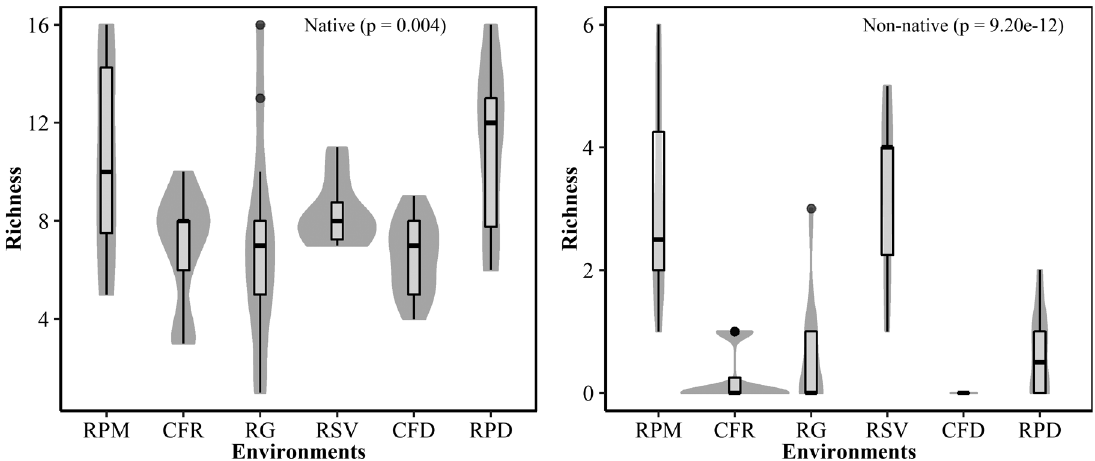
FIGURE 4 | Observed fish-species richness vs . environments. Violin plot comparing the median, interquartile range, and 95% confidence interval on the distribution pattern of richness among environments (left: native fish, right: non-native fish). The shape of the violin plot represents data distribution by kernel-density estimation, meaning that wider sections represent a higher probability of that given value of richness in that environment; the skinnier sections represent a lower probability. P-values from Kruskal–Wallis test for richness among environment is displayed. The environments were identified from upstream to downstream direction, as follows: (RPM) Porce River isolated between the dams, (RG) Guadalupe River, (RSV) Reservoir, (CFR) Creeks flowing to the reservoir, (CFD) Creeks flowing to the Porce River below the dam and (RPD) Porce River below the Porce III